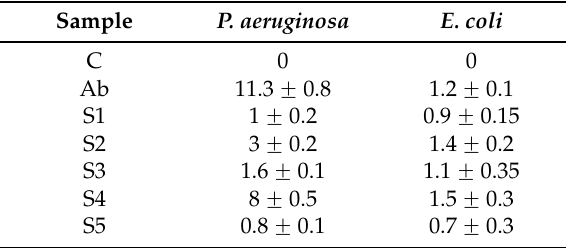
Figure 7. Escherichia coli zones of inhibition (ZOI) around silver nanoparticles (AgNPs) impregnated disks. The distance of the bacterial lawn from disk/ZOI is demonstrated by red lines. Table 3. Average zone of inhibition (mm) of silver nanoparticles (AgNPs) against Pseudomonas aeruginosa ( P. aeruginosa ) and Escherichia coli ( E. coli ).